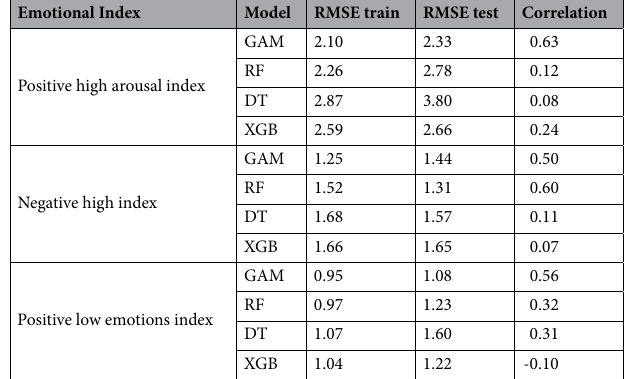
Table 5. Performance of nonlinear modelling methods comparisons and correlation between actual and predicted values on test and training sets. RMSE root mean square error, GAM generalized additive model, RF random forests model, DT decision trees model, XGB eXtreme gradient boosting